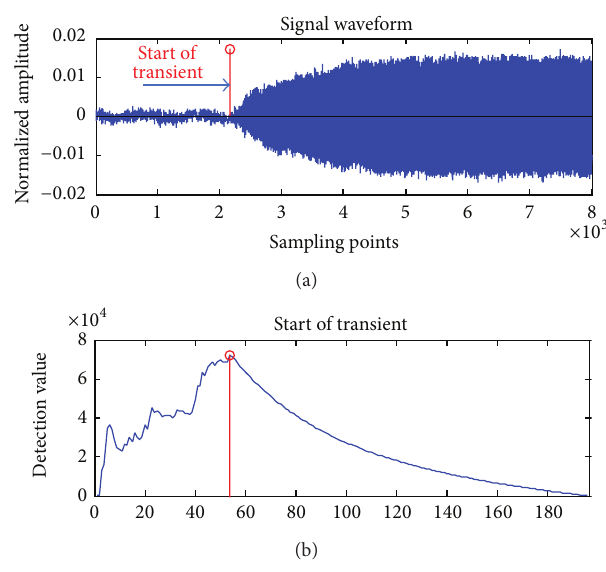
Figure 4: The detection for the start of wireless transmitter tran-